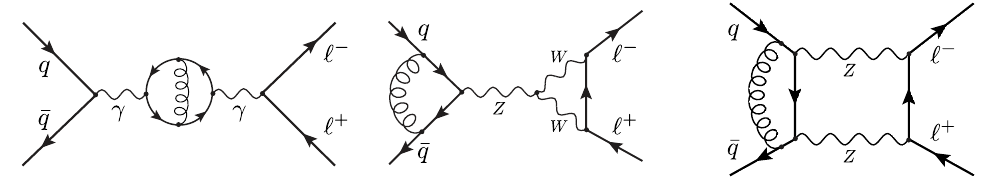
Figure 1 . Examples of Feynman diagrams that contribute to the two-loop amplitude. Left: two-loop fermionic non-factorizable corrections, middle: factorizable corrections, right: bosonic non-factorizable